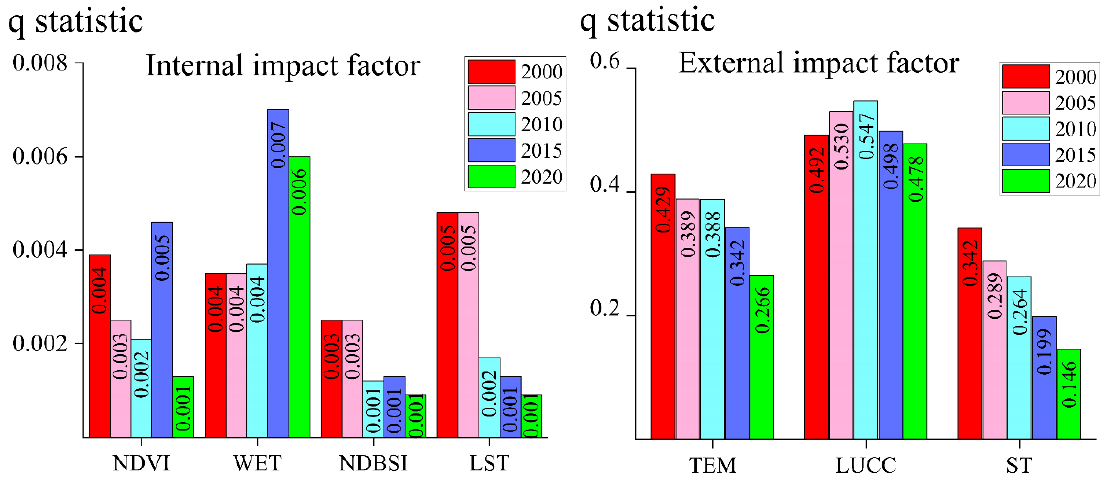
Figure 8. Spatial heterogeneity factor detection results.